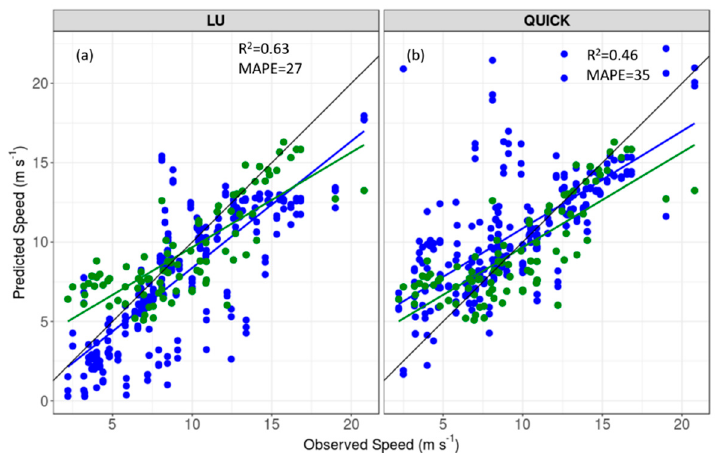
Figure 18. Observed versus predicted wind speeds at all sites using the ( a ) linear upwind and ( b ) QUICK discretization schemes. Blue symbols are for the CFD solver and green symbols are for the COM solver. The blue and green lines represent the ordinary least squares line of best fit for the CFD and COM solver, respectively. The black line is the 1:1 line. The mean absolute percent error (MAPE) and coefficient of determination (R 2 ) for the COM solver are 29 and 0.60, respectively. Table 8. Model root mean square error (RMSE), mean bias error (MBE), and mean absolute percent error (MAPE) for wind speeds at all locations at all sites. Positive MBE indicates model over ‐ prediction. Bold font indicates the lowest error at each location.